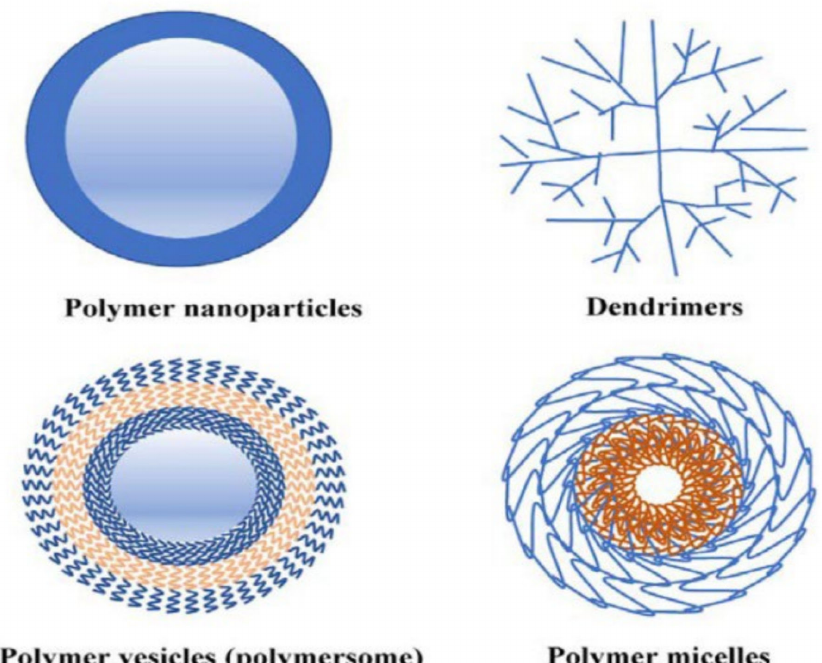
Figure 4. The classification of polymeric nano carriers (adapted from